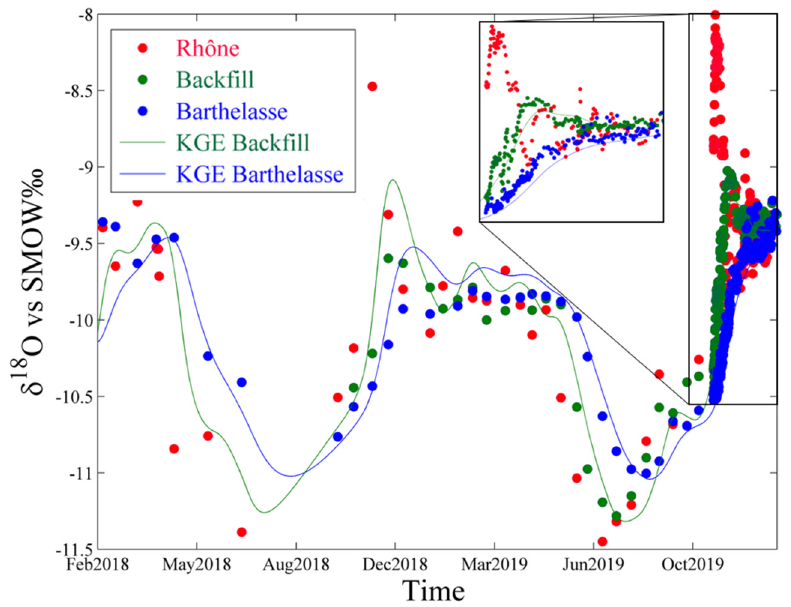
Figure 14. Evolution of δ 18 O in the Rhône, backfill and Barthelasse after combining flood monitoring and annual monitoring.